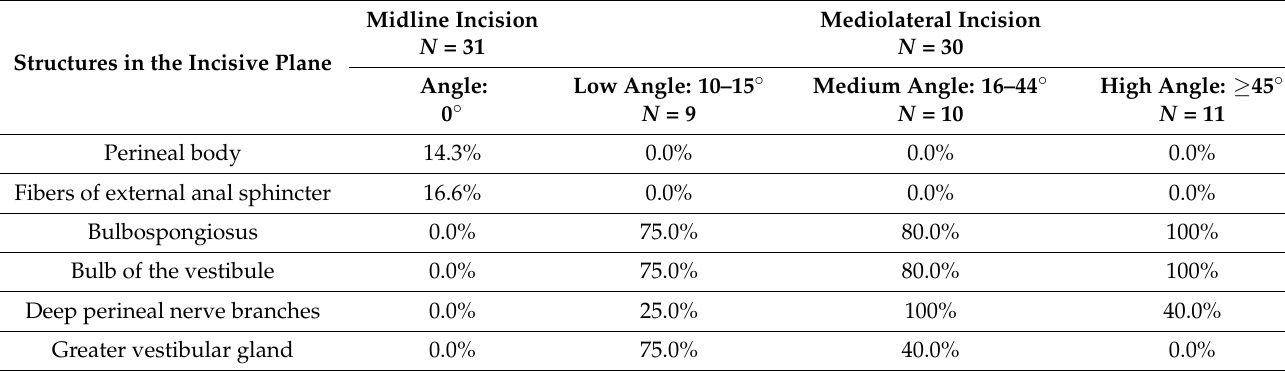
Table 1. Percentage of females with structures located in the plane of